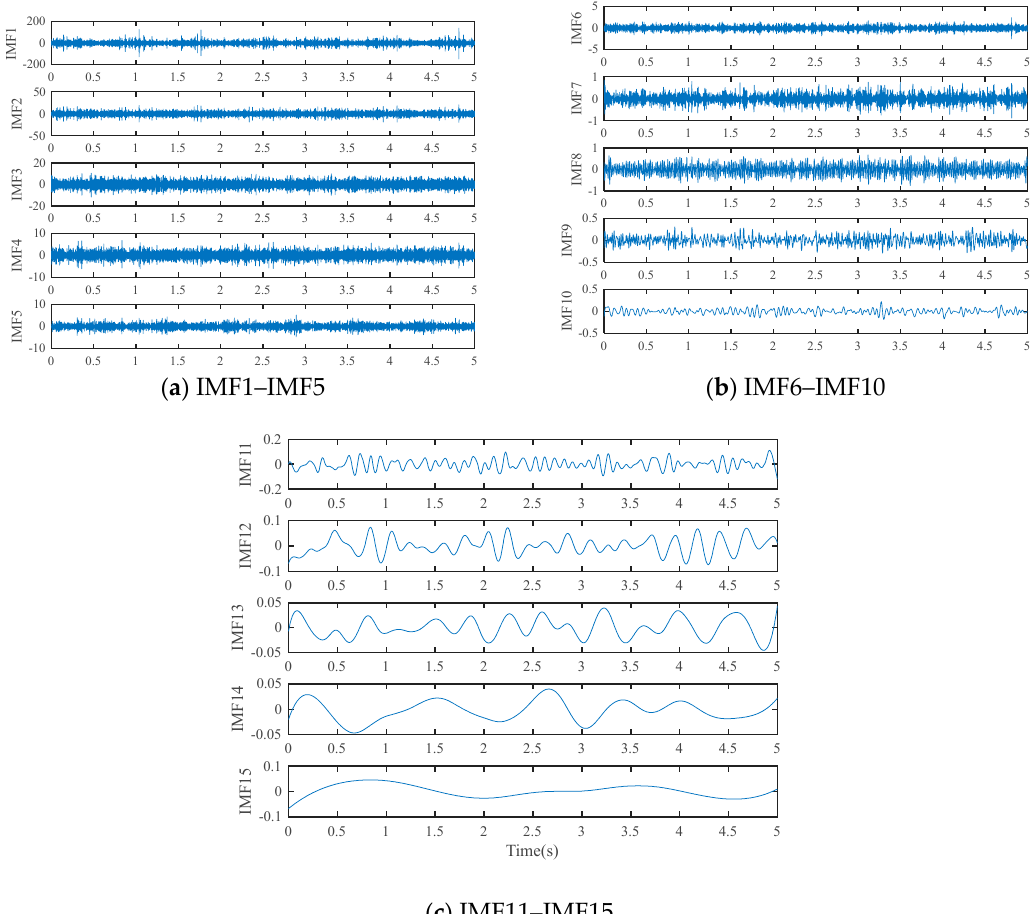
Figure 6. Results of fault signal analyzed by ensemble empirical mode decomposition (EEMD).